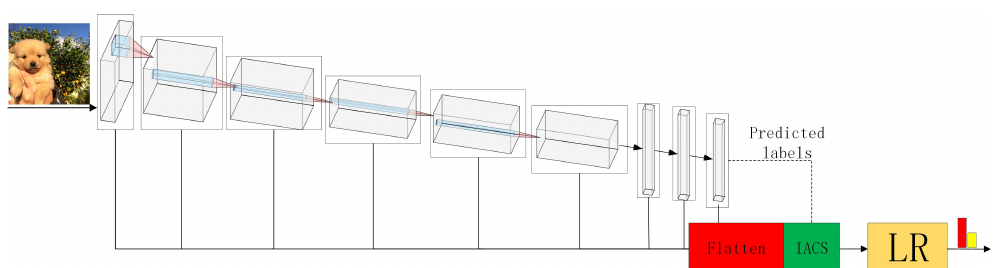
Figure 1. An overview of our detection method based on inner-class adjusted cosine similarity (IACS): We first extract the features of each layer and flatten them into one dimension. Then, the extracted features and predicted label information are used to calculate the IACS and further train the linear regression classifier to discriminate the IACS values of adversarial examples from those of normal